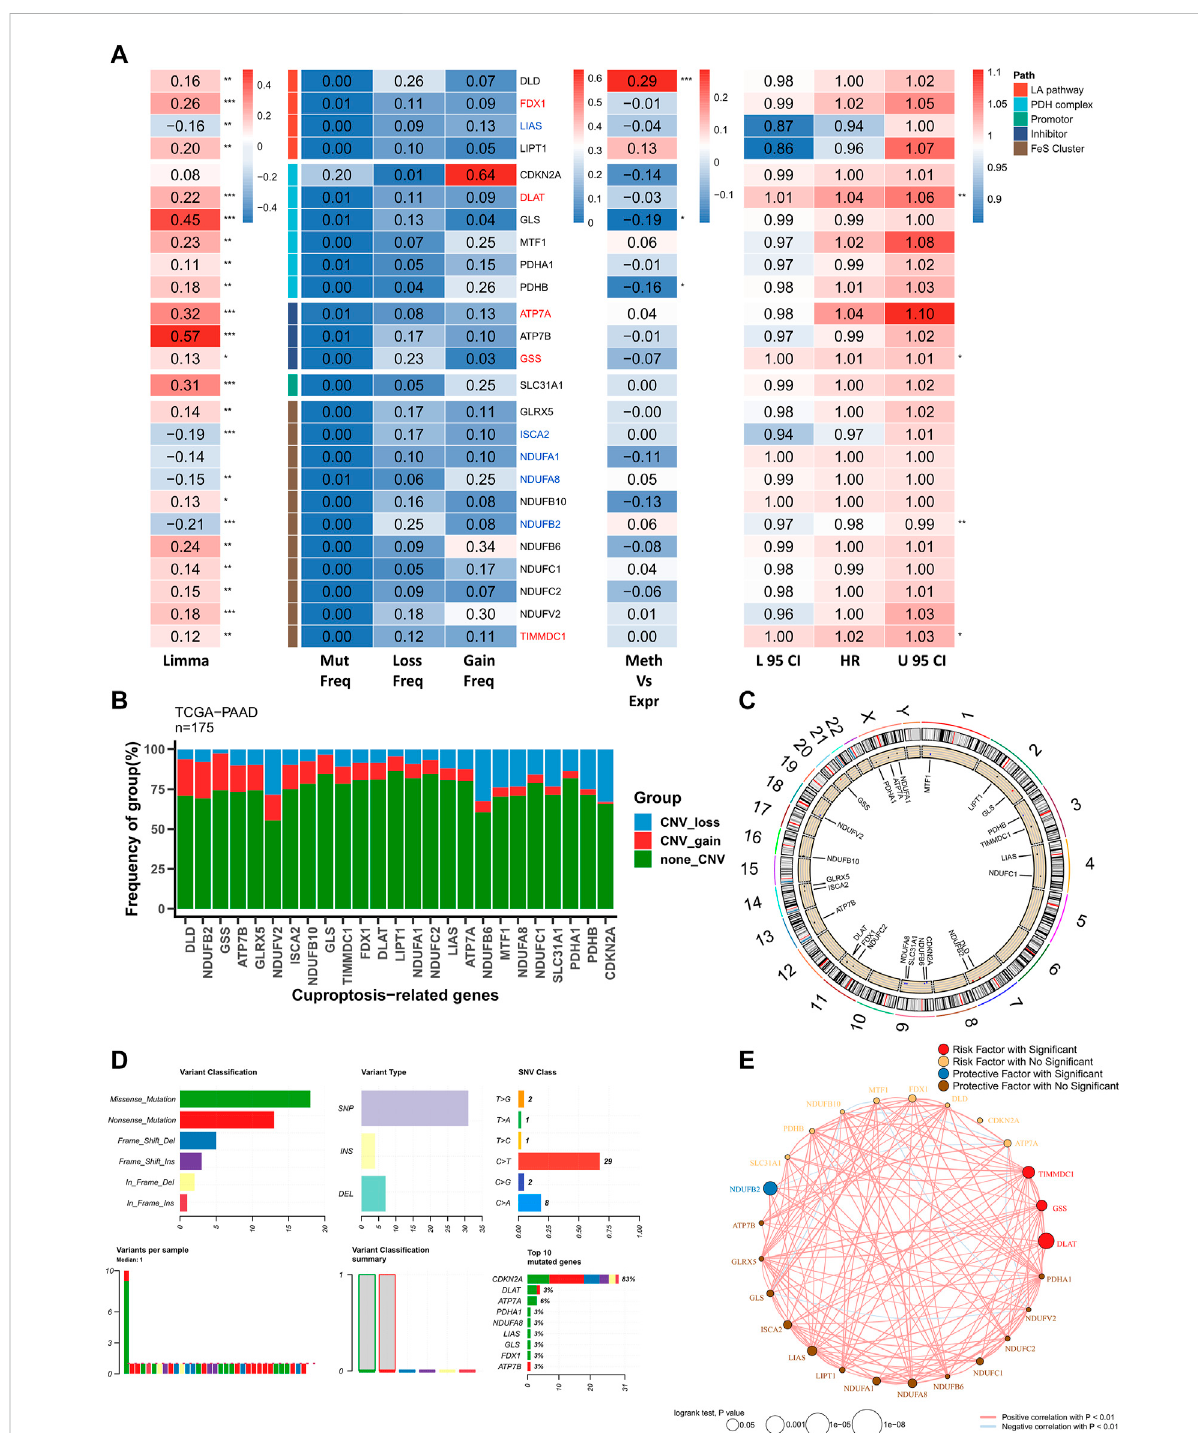
FIGURE 1 Genomic pro fi le of CRGs in PAAD. (A) Heat map showing genomic variations and hazard ratios of CRGs in TCGA – PAAD; from left to right: mutation and CNV frequencies of CRGs, the correlation between DNA methylation modi fi cations of CRGs and CRG expression; univariate Cox regression analysis showing risk ratios of FRGs. * p < 0.05, ** p < 0.01, *** p < 0.001; (B) Bar chart showing CNV events in CRGs in TCGA – PAAD; (C) Circle plot showing CNV events of CRGs on chromosomes; (D) Summary of CRG mutation events in TCGA – PAAD; (E) Correlation network of CRGs ( p <